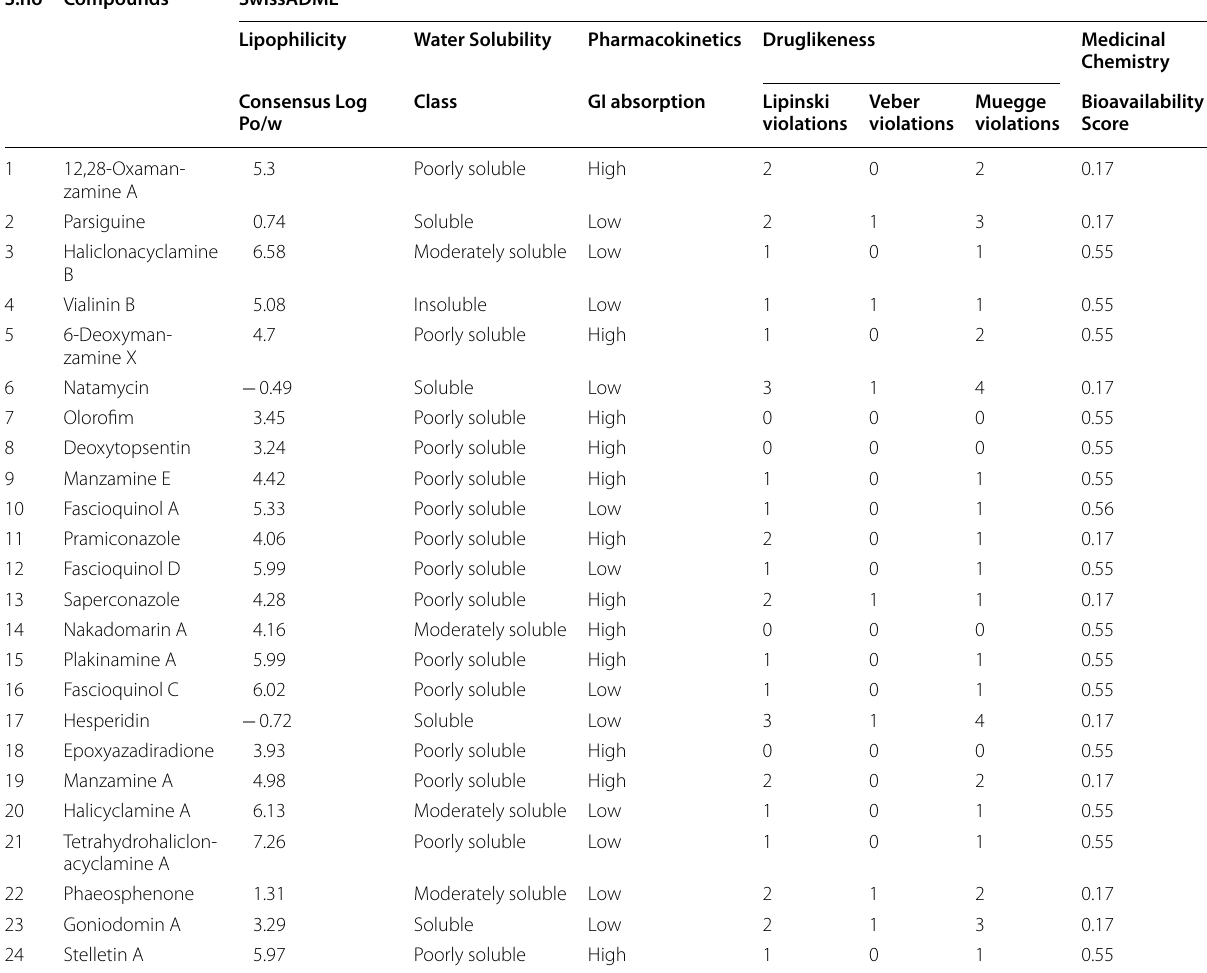
Table 7 ADME analysis of top ligands docked against our 3 target proteins S.no